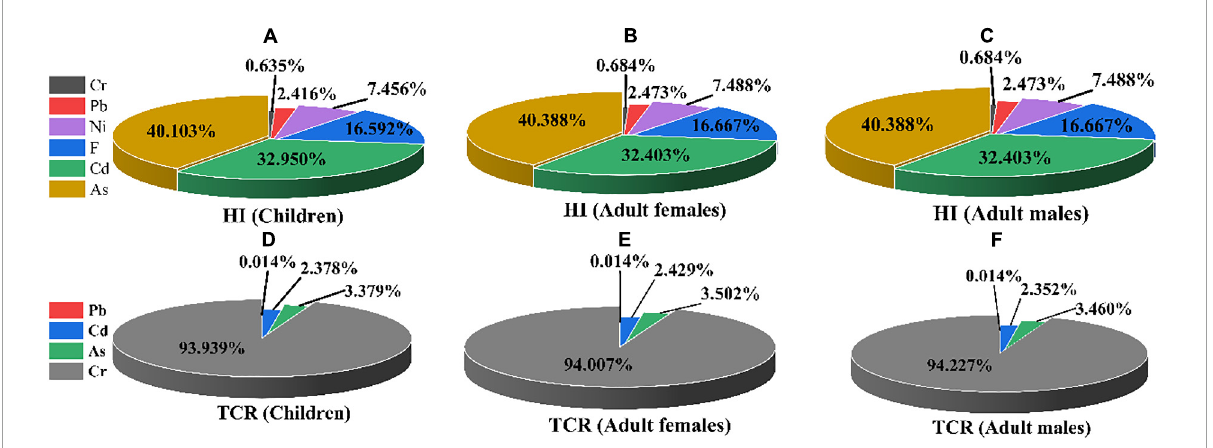
FIGURE5 The contribution of hazard index (HI) and threshold carcinogenic risk (TCR) for children, adult females, and adult males. [ (A–C) for HI; (D–F) for TCR].